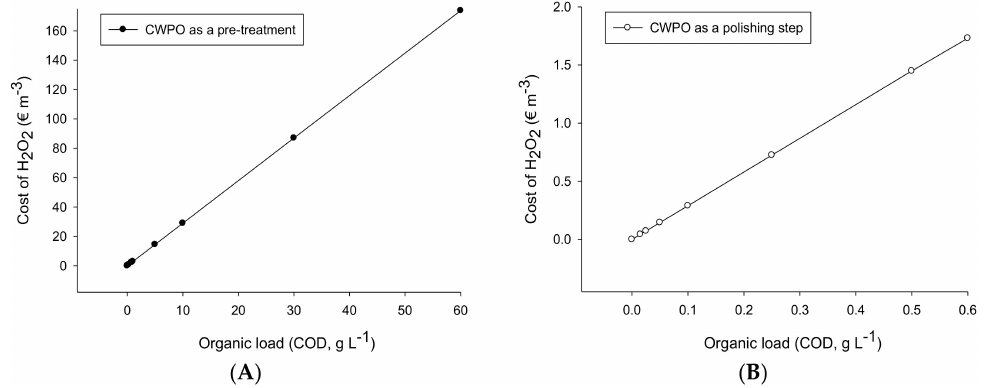
Figure 5. Cost of the H 2 O 2 reagent as a function of the initial wastewater TOC (when stoichiometric amount of H 2 O 2 is added) for CWPO as pre-treatment ( A ) and as a post-treatment ( B